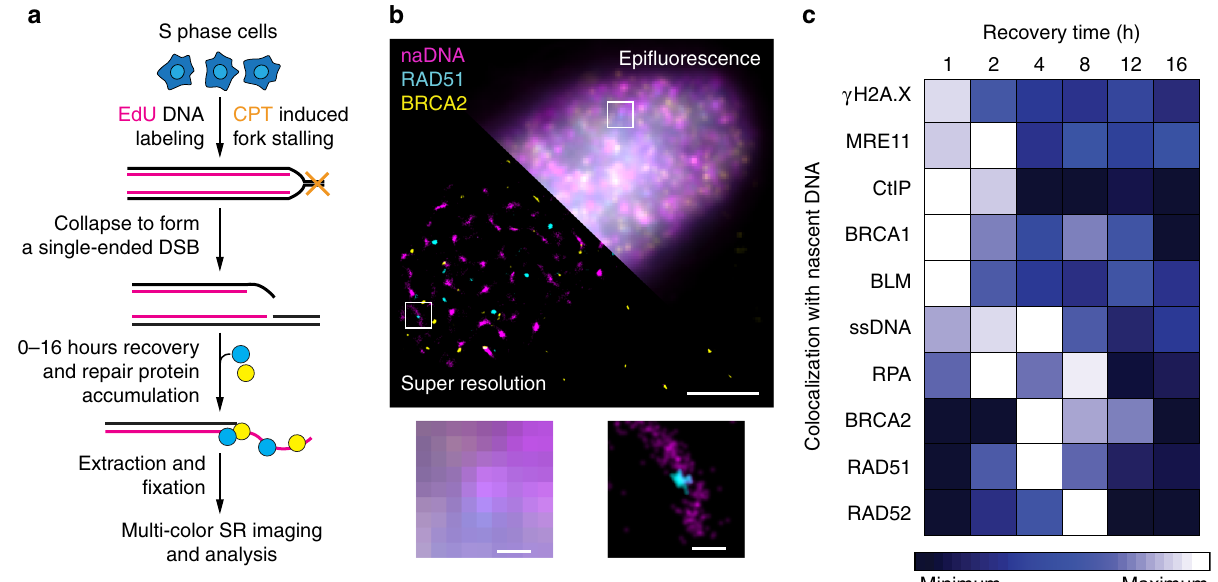
Fig. 1 Super-resolution spatiotemporal mapping of the arrivals, accumulations, and departures of repair proteins at individual seDSBs in human cells. a Damage and labeling scheme used to generate and visualize seDSB repair foci. b Representative epi fl uorescence (upper right) and super-resolution (lower left) images of a single nucleus damaged and labeled for naDNA (using EdU, magenta), RAD51 (cyan), and BRCA2 (yellow). Representative zoomed in epi fl uorescence (bottom left) and super-resolution (bottom right) foci shown. Whole-cell image scale bar = 3 μ m, zoomed sections = 250 nm. c Spatiotemporal heatmap describing the arrival, accumulations, and departure kinetics of repair proteins, as well as ssDNA and histone modi fi cation γ H2A. X, over 16 h of recovery. For complete N values, see Supplementary Table 1. For Student ’ s t test analysis for signi fi cance, see Supplementary Fig.